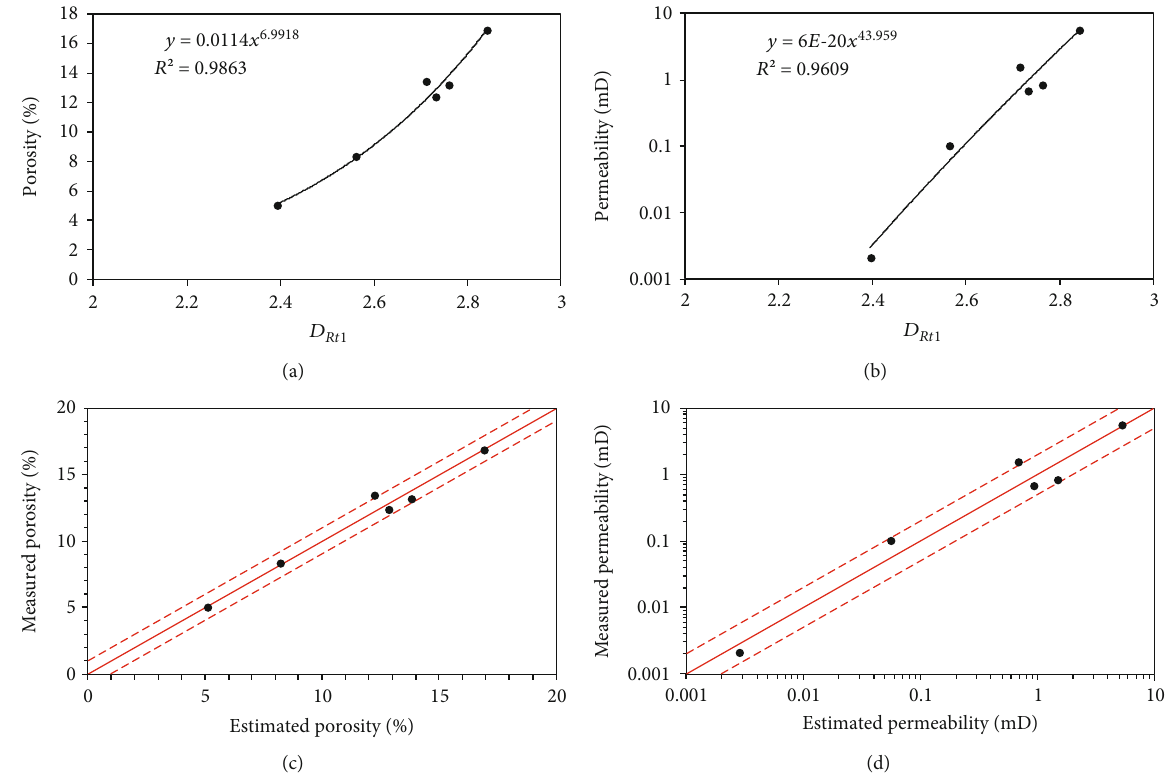
Figure 15: Plot of D versus (a) porosity and (b) permeability from six typical specimens. Comparison between estimated and measured (c) Rt 1 porosity and (d) permeability for six typical specimens by equations (18) and